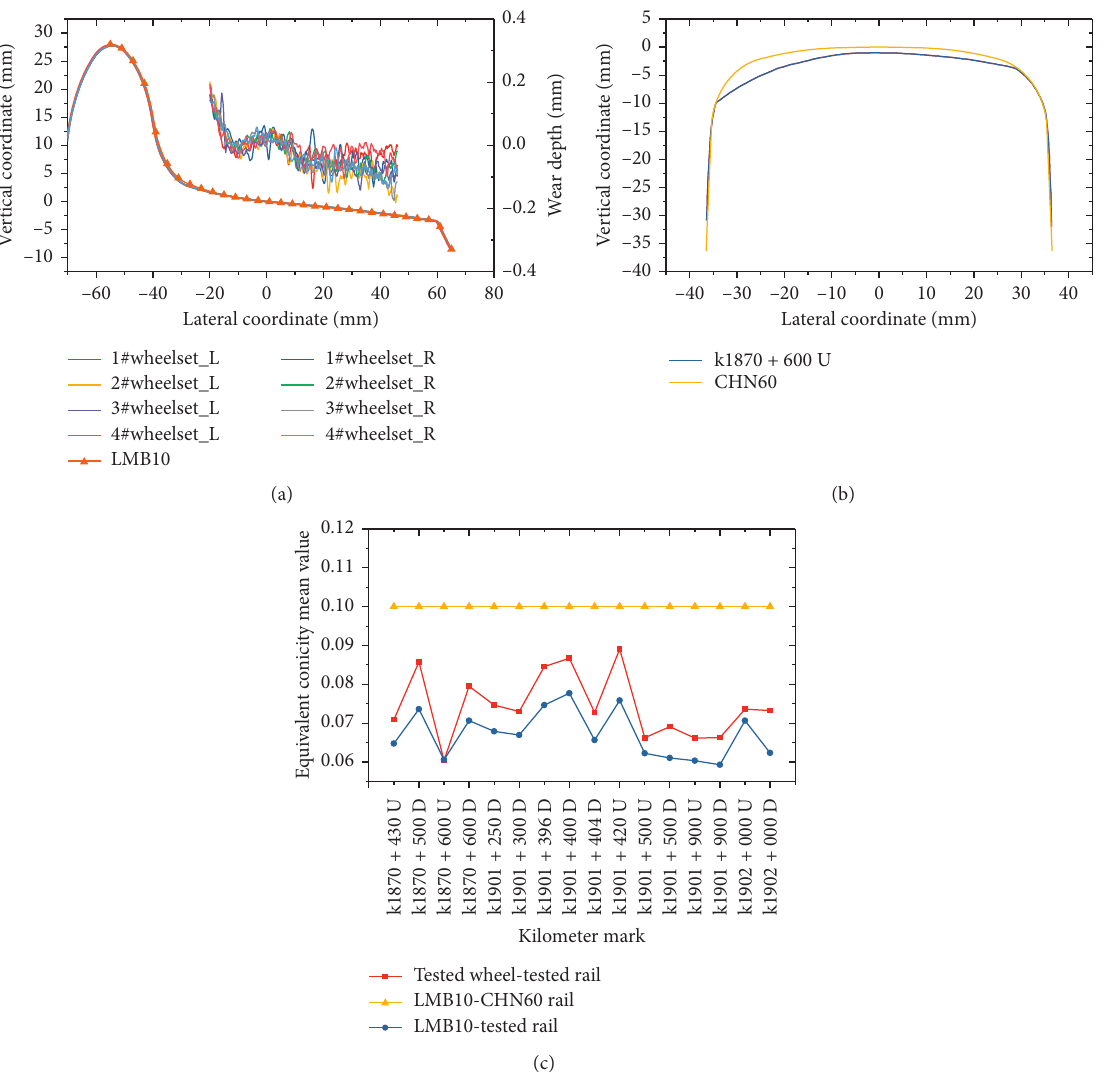
Figure 3: The profile of (a) wheelsets, (b) rail, and (c) the equivalent conicity mean value (U means the upline, which represents train‘s running direction towards Beijing, and D means the downline, which represents train‘s running direction away from